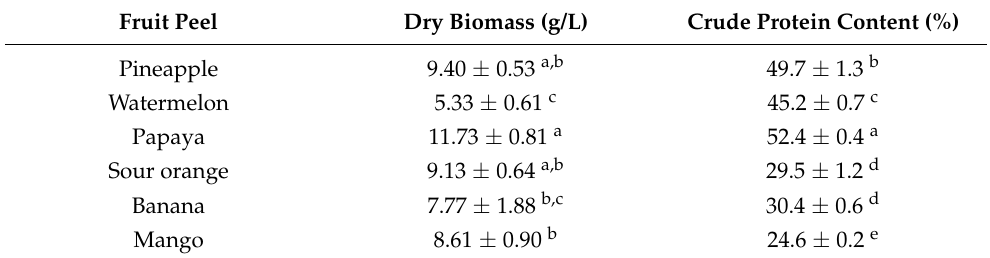
Table 2. Dry weight and crude protein content of dry biomass produced from various fruit peels. Fruit